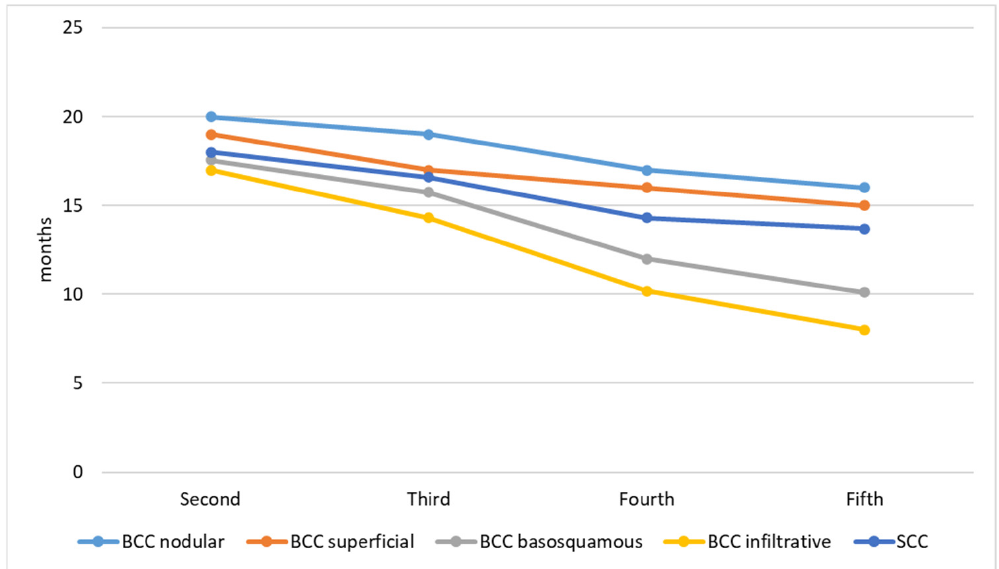
Figure 2. Timing between subsequent primary KC development.